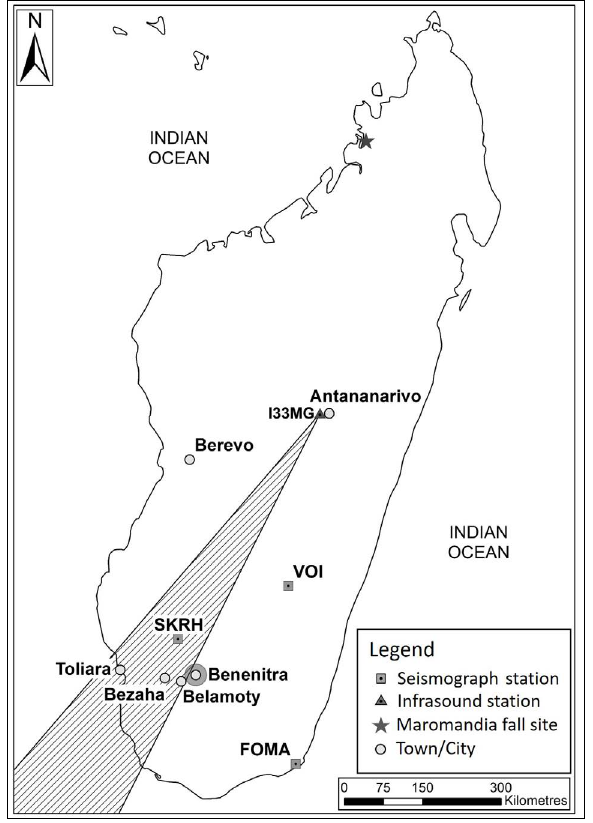
Figure 1: Map of Madagascar showing the locations of Benenitra, the Com- pre hensive Nuclear Test Ban Treaty Organization station I33MG and the SKRH, VOI and FOMA seismograph stations. The star indicates the location of the Maromandia fall of 5 July 2002. The hatched region indicates the vector range of the infrasound sources detected at I33MG (Figure 3b) and the dark grey circle marks the 20-km radius from Benenitra as used in the model in Figure